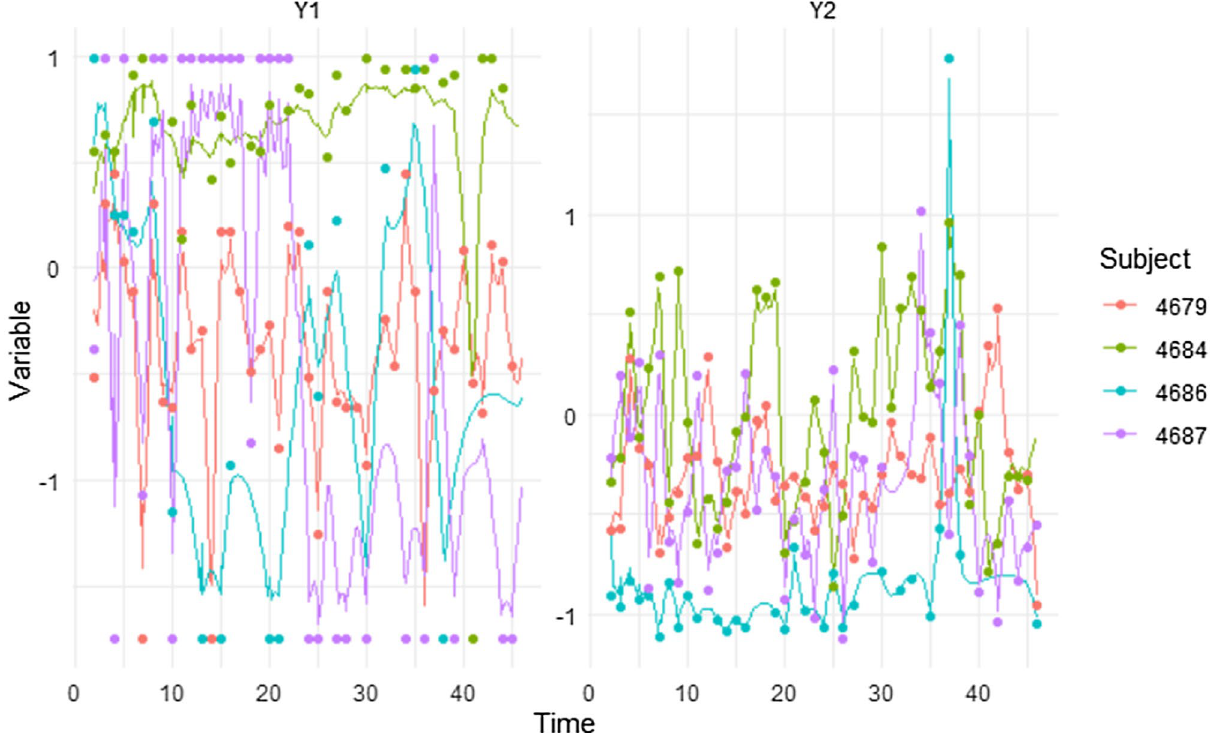
Figure 5. Observed data points of well-being (Y1) and frequency of use (Y2) for four specific subjects over 44 days. Auto-effects of Y1 are more stable over time, whereas Y2 showed more